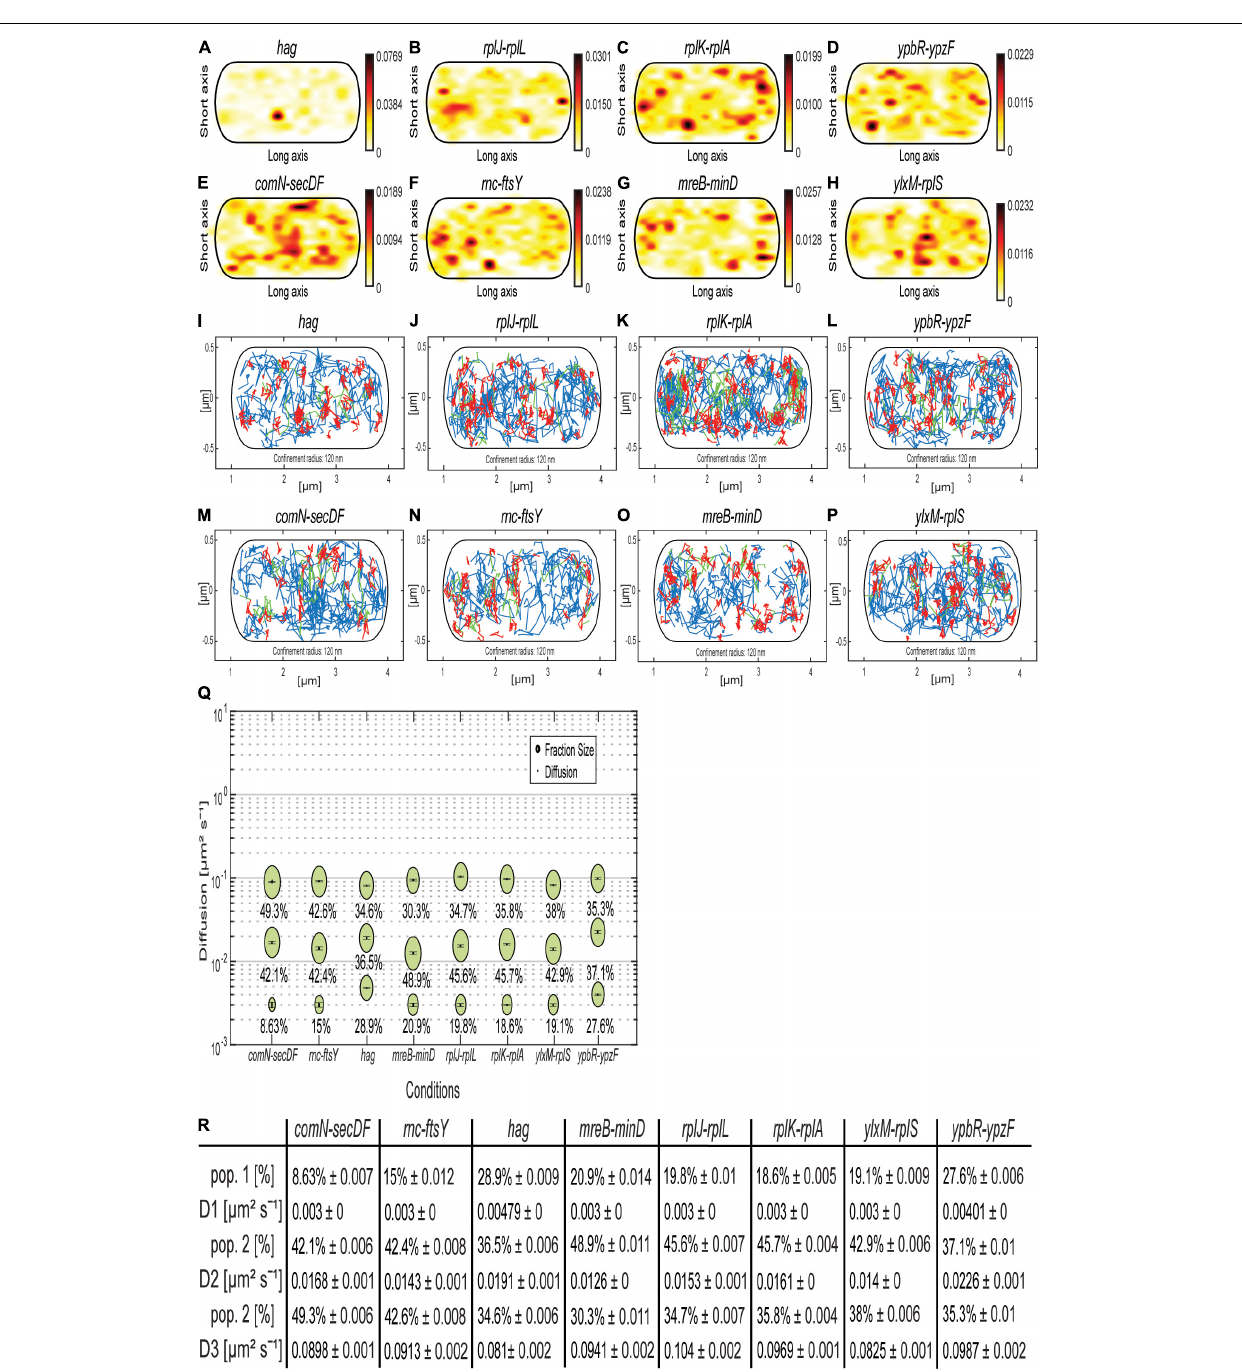
Frontiers in Microbiology |